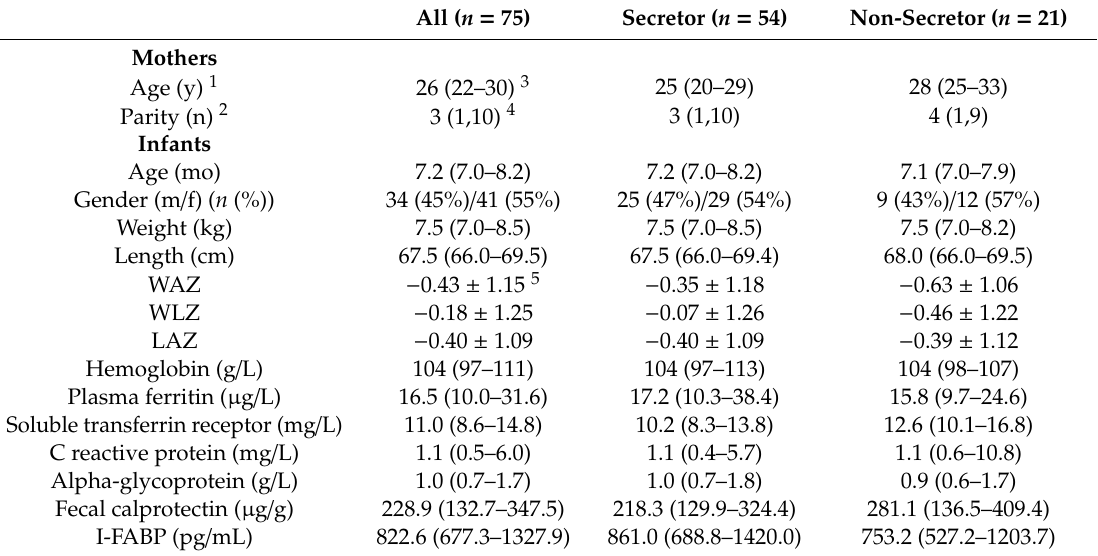
Table 2. Characteristics of the study population at baseline. Age, parity, gender, anthropometrics, hematological and inflammation status, fecal calprotectin and plasma I-FABP. Di ff erences in these variables among Kenyan mothers ( n = 75) and Kenyan infants ( n = 75) at baseline, by maternal secretor status. All ( n =